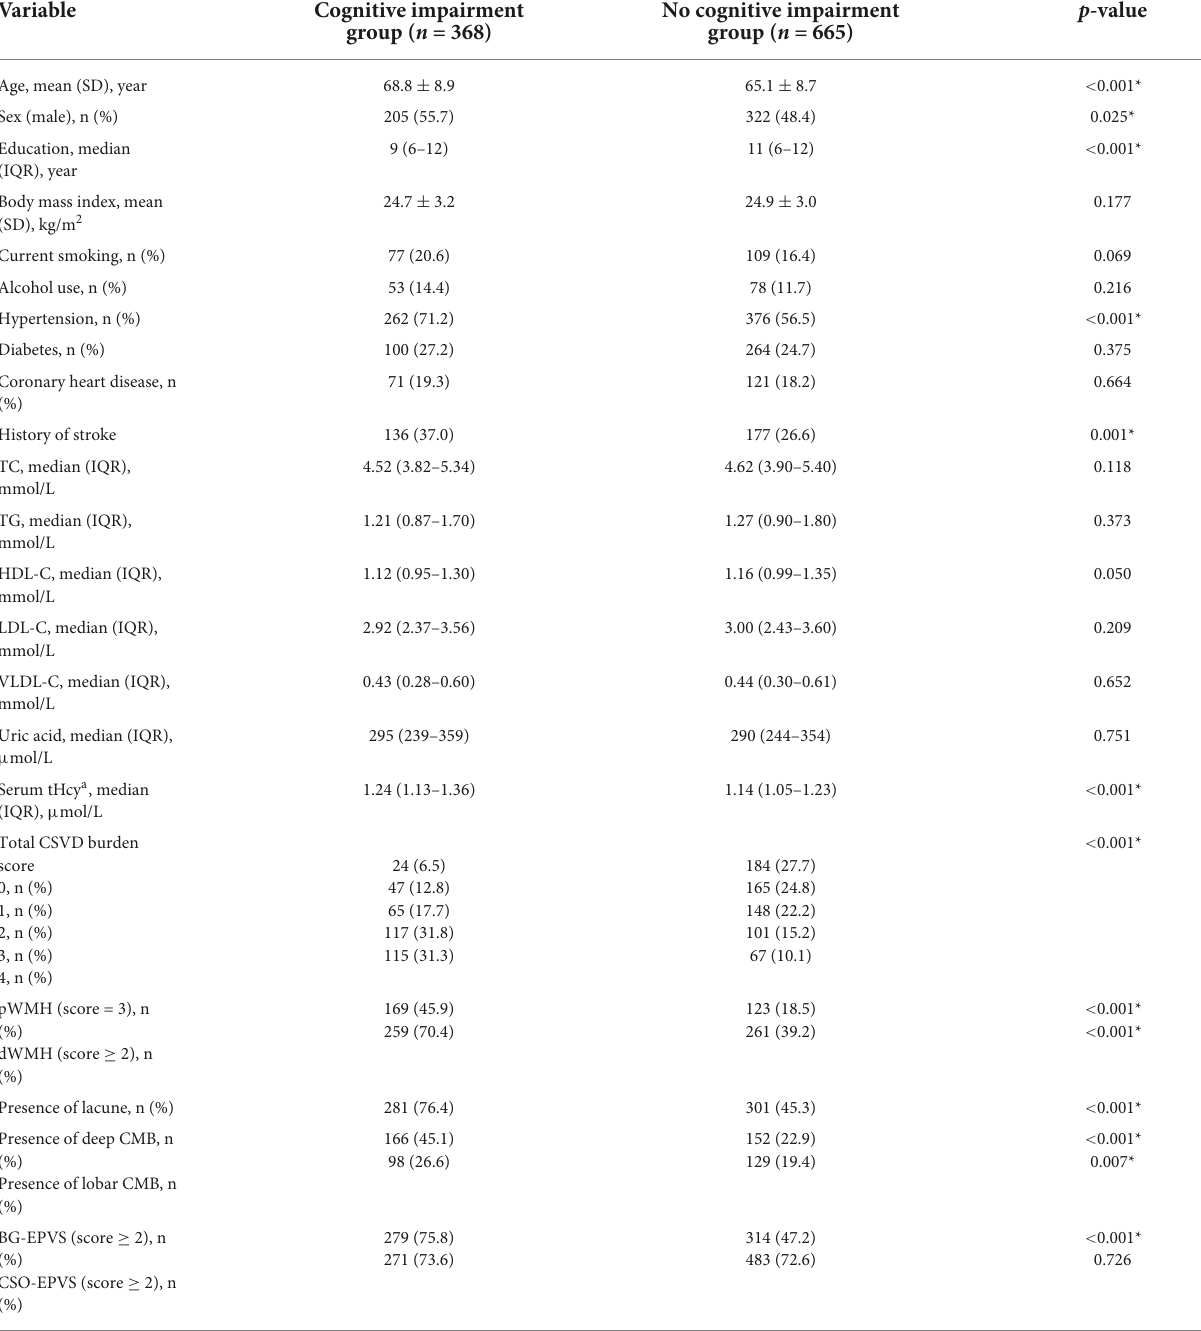
TABLE 1 Characteristics of the study participants between cognitive impairment and no-cognitive-impairment groups. Variable Cognitive impairment group ( n =